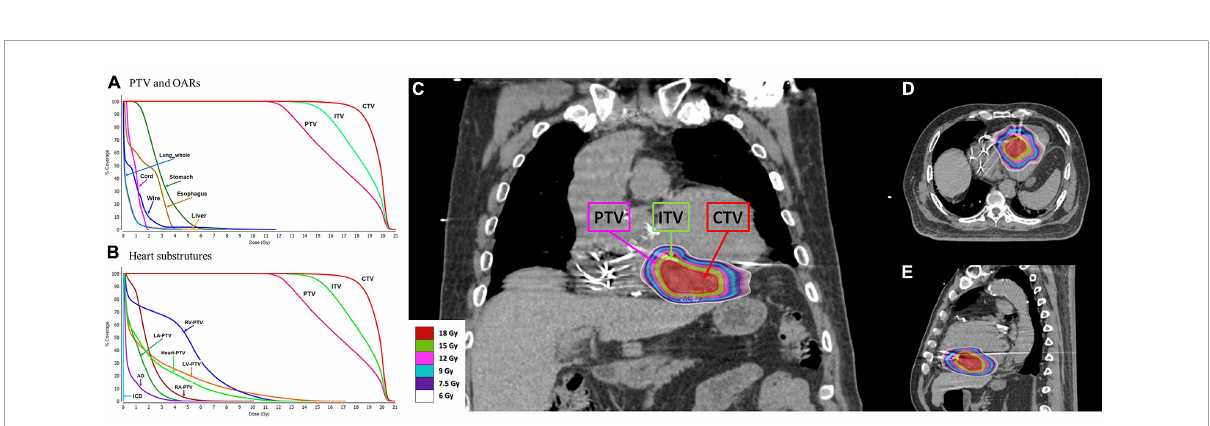
FIGURE4 The substrate was targeted at the clinical target volume (CTV). An internal target volume (ITV) was created from the phased-binned 4D CT images to account for the maximum range of motion that was assessed by reviewing the playback of all the phases of the 4D-CT overlaid with the reference CT scan. The planning target volume (PTV) was generated as a 3-mm volumetric expansion from the ITV. The goal was for at least ≥ 95% of the PTV to be covered by at least 95% of the prescribed dose (12 Gy). Optimization was performed to place prescription hotspots (areas receiving > 100% of the prescribed dose) within the ITV and CTV, enabling the ITV and CTV to be covered by up to 125% and 150% of the prescribed dose, respectively. (A) Dose volume histogram (DVH) for the PTV and organs at risk. (B) DVH for the PTV and heart substructures. RV, right ventricle; LV, left ventricle; RA, right atrium; LA, left atrium; AO, aorta; ICD, cardioverter-defibrillator. (C) Coronal view of the plan with color wash. (D) Transverse view of the plan with color wash. (E) Sagittal view of the plan with color